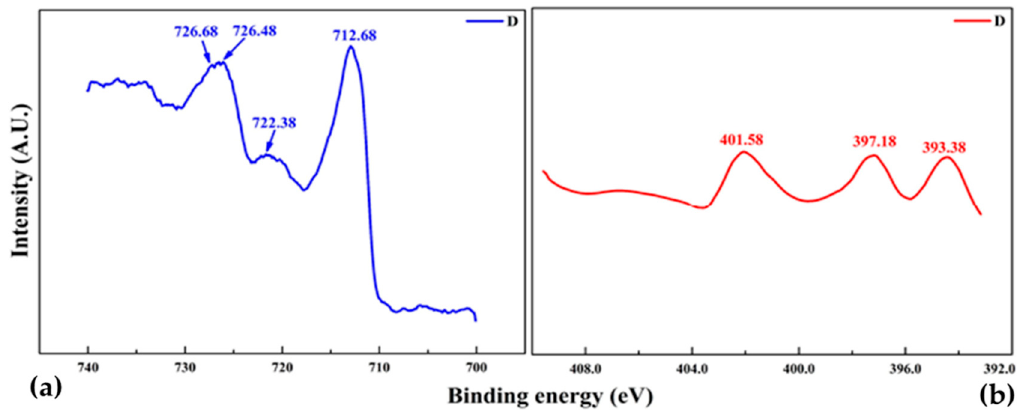
Figure 13. X-ray photoelectron spectra of FeN thin film sputtered on both sides. ( a ) Fe 2 P and ( b ) N1s.